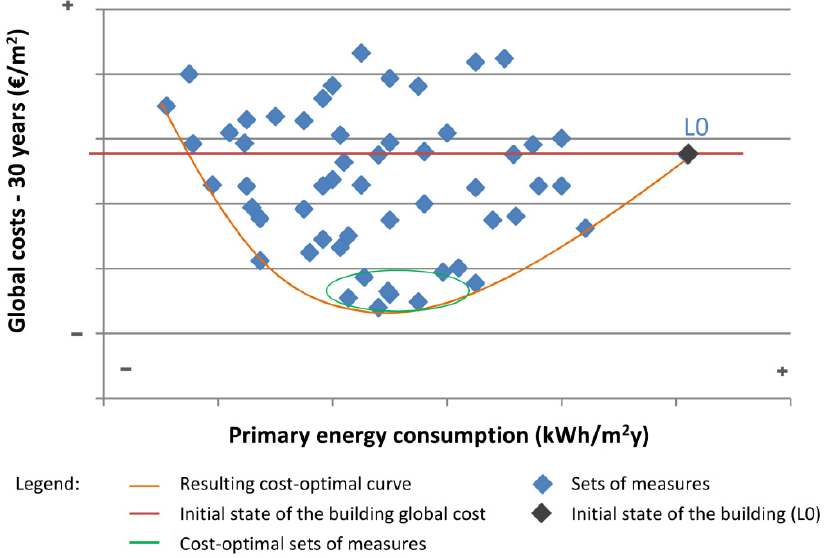
Figure 3. Example of cost-optimal graph. Correlation between the 30-year global costs of sets of measures proposed per m 2 , and building’s primary energy consumption per m 2 and year.